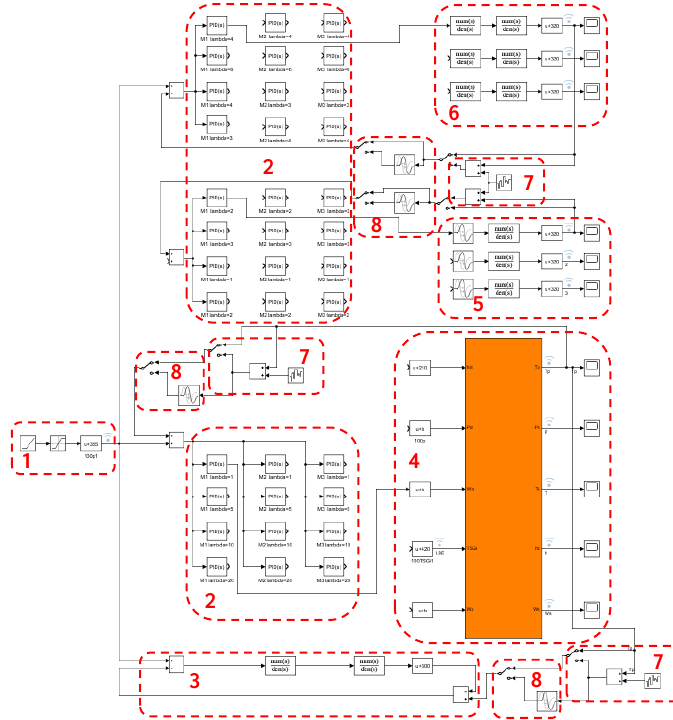
Figure 9. Structure of the OTSG feedwater control simulation platform.